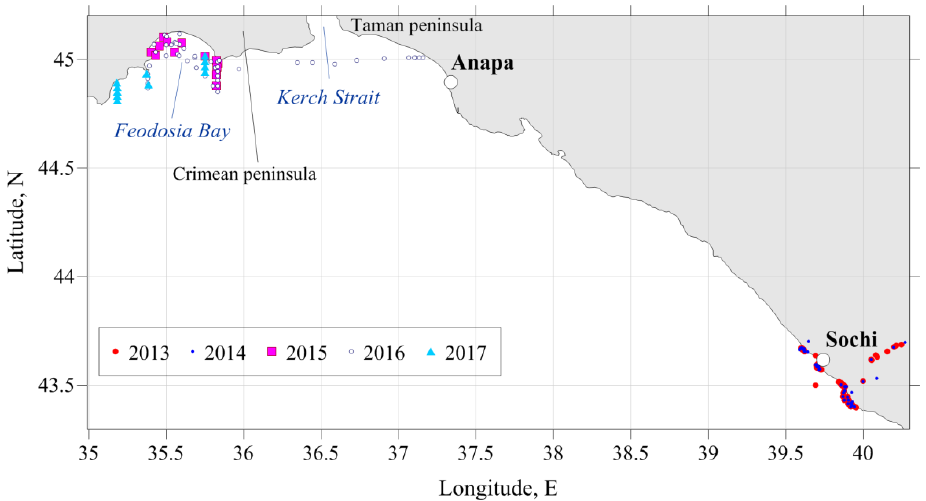
Figure 1. Location of water sampling stations in the sea and rivers of the Sochi and the Feodosia Bay regions in 2013–2017.